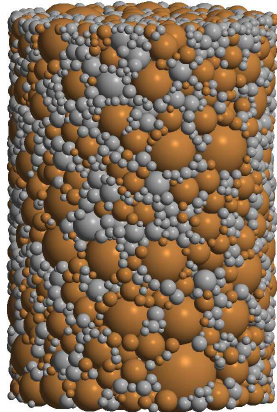
Figure 5. Discrete element specimen of two-phase 80%NiAl-20%Al 2 O 3 powder.